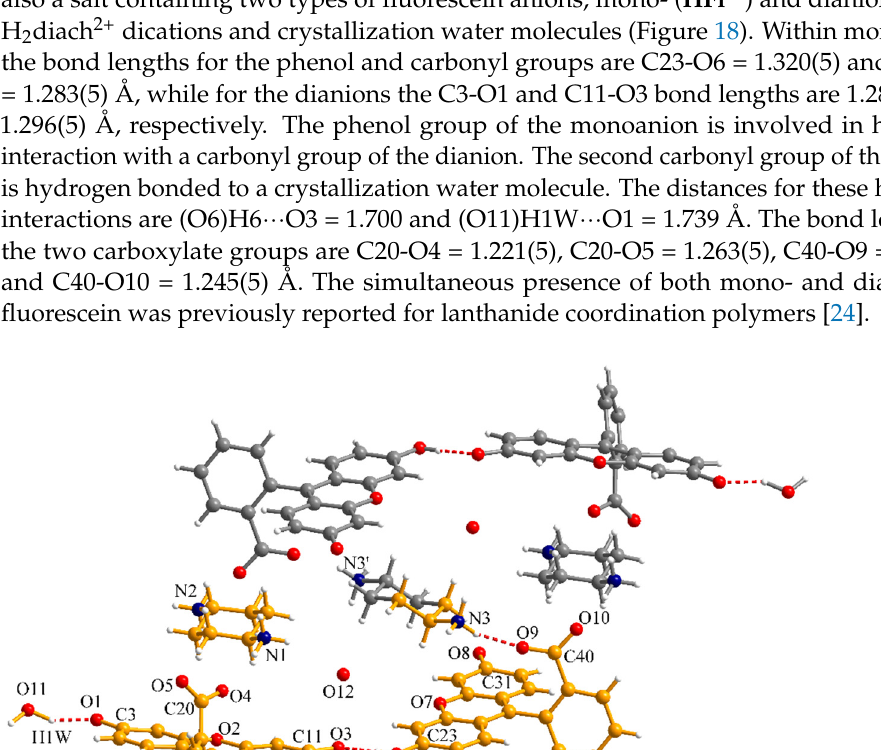
The compound 10 , [(HFl) 2 (Fl) 2 (H 2 diach) 3 ] ∙ 4H 2 O, was obtained initially as by-product